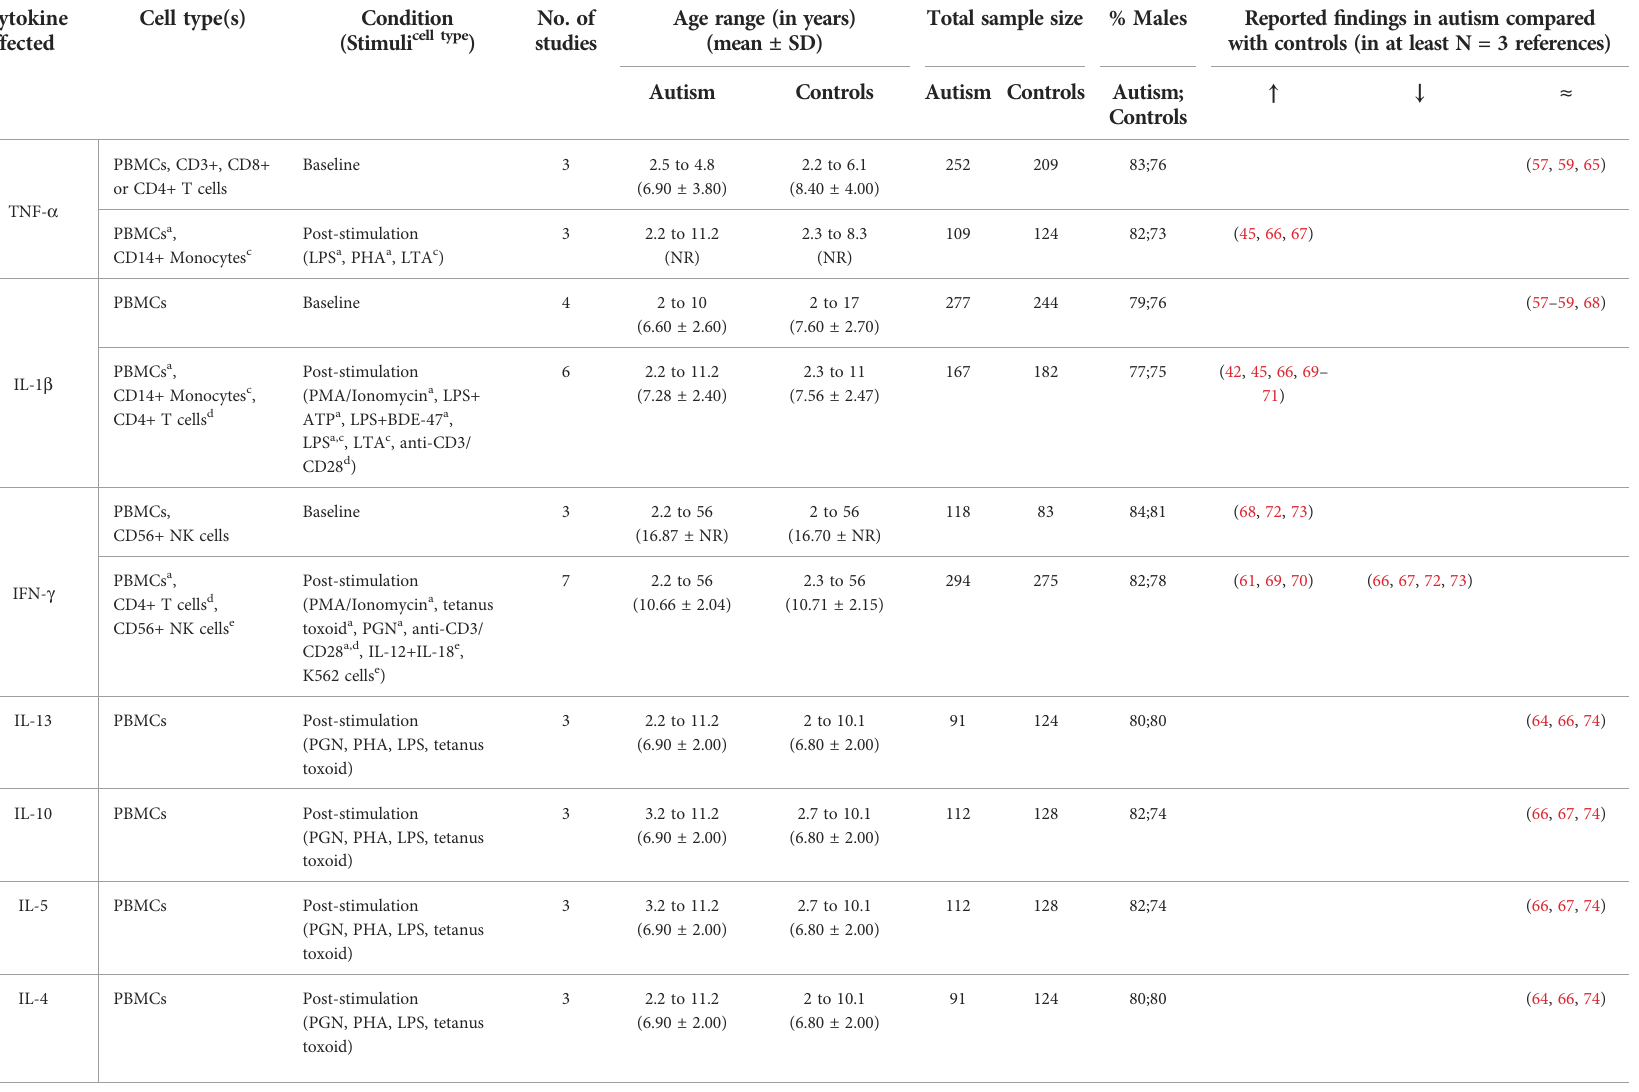
Symbols: ↑ , increased; ↓ , decreased; ≈ , unchanged; in autism compared with controls. ATP, adenosine triphosphate; BDE-47, 2,2 ’ ,4,4 ’ -tetrabromodiphenyl ether; CD, cluster of differentiation; IFN- g , interferon- g ; IL, interleukin; LPS, lipopolysaccharide; LTA, lipoteichoic acid; NK, natural killer; NR, not reported; PBMCs, peripheral blood mononuclear cells; PGN, polymeric peptidoglycan; PHA, phytohemagglutinin; PMA, phorbol myristate acetate; TNF- a , tumor necrosis factor- a